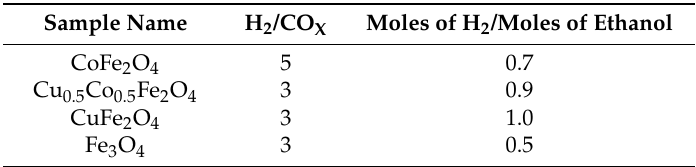
Table 5. Chemical-loop process parameters calculated for MFe 2 O 4 ferrites in bioethanol reforming (note: Listed data correspond to the values obtained after 3 complete cycles of 20